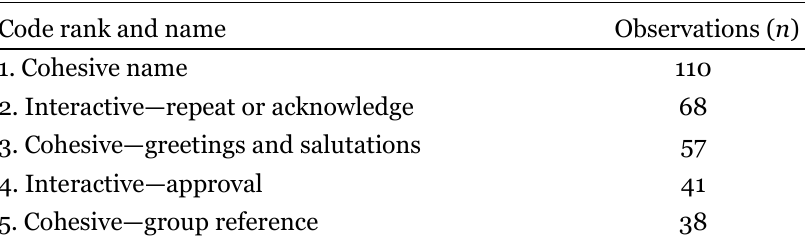
Top Five Instructor Social Presence Codes Observed Code rank and